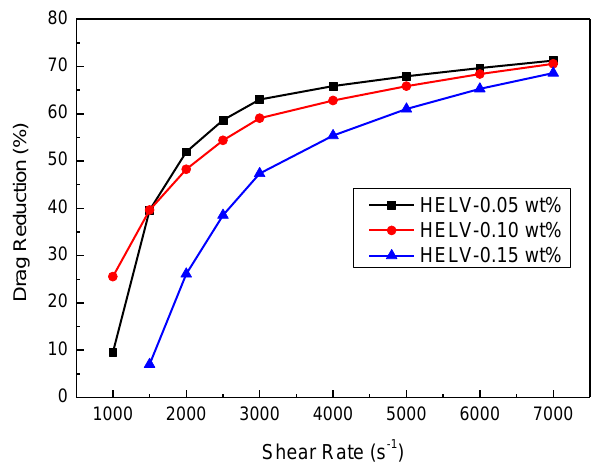
Figure 18. The variation of drag reduction rate between HELV concentrations at di ff erent shear rates.